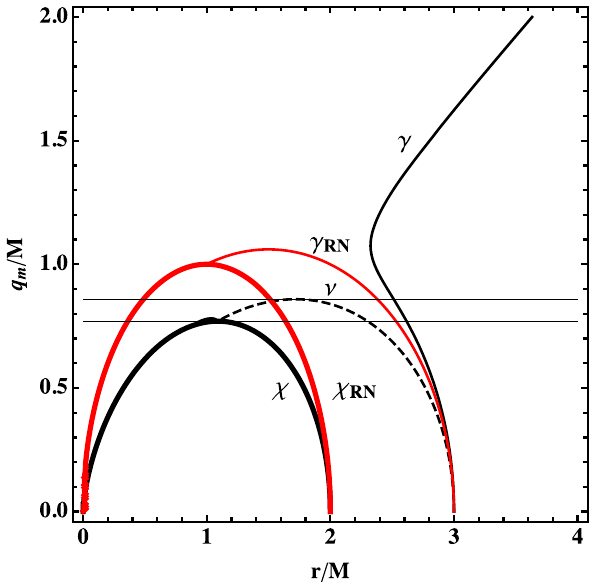
Fig. 1 The loci of circular orbits in r − q plot ( r -the radial coordinate and q -the magnetic charge parameter) of photons in effective Bardeen geometry ( γ ) and neutrinos ( ν ) in Bardeen spacetime. Curve χ repre- sents loci of the Bardeen spacetime horizons. Curve χ RN represents loci of the Reissner–Nordstrom spacetime horizons. Note that from the spacetime interval (5) it follows that horizons of g μν and ˜ g μν coincide